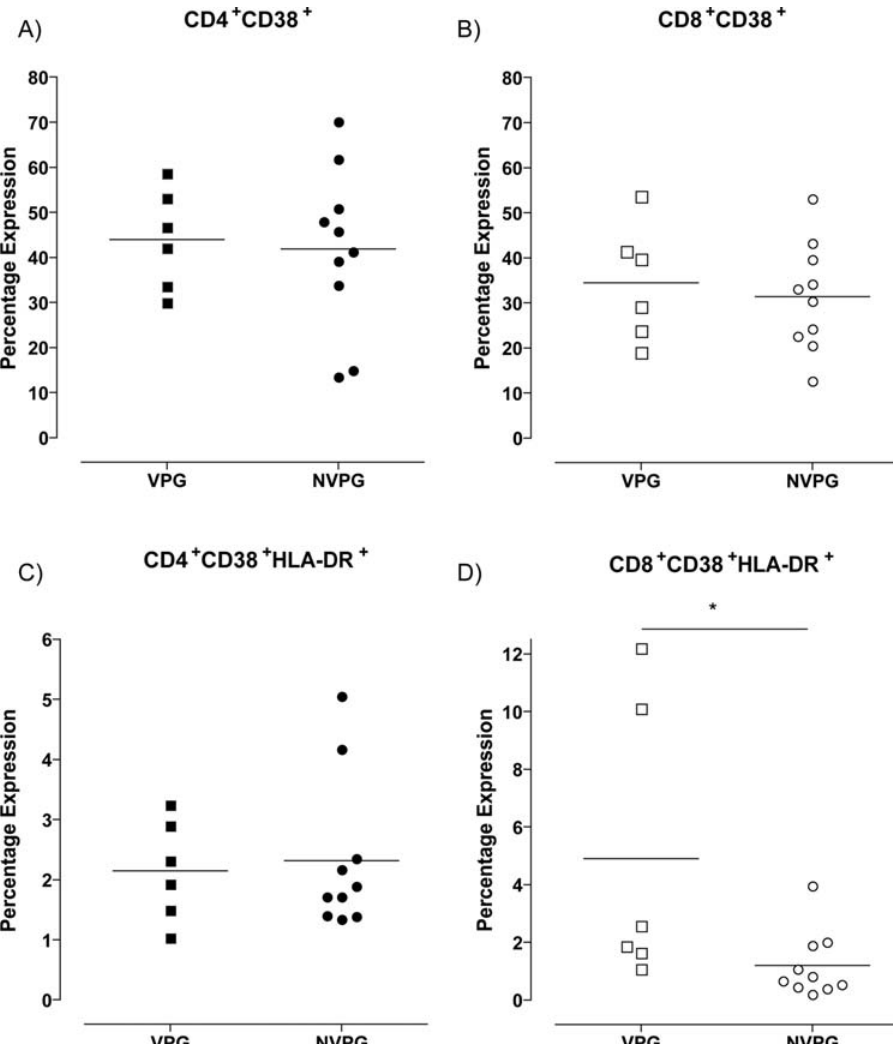
Figure 6. Total T cell activation was not influenced by exposure. The expression level of activation markers CD38 and HLA-DR were compared between VP group (squares, n=6) and NVP group (circles, n=10). The expression of CD38 on total CD4 + (A) and total CD8 + (B) T cells showed no significant difference. No significant difference was seen in CD4 + T cell co-expression of CD38 and HLA-DR (C). However, CD8 + T cells from the VP group co-expressed significantly higher of CD38 and HLA-DR compared to the NVP group (denoted by *) (D). doi:10.1371/journal.ppat.1000185.g006 Table 3. Clinical data of 8 individuals from VPG at time point 0 and 1 year later at time point 1.